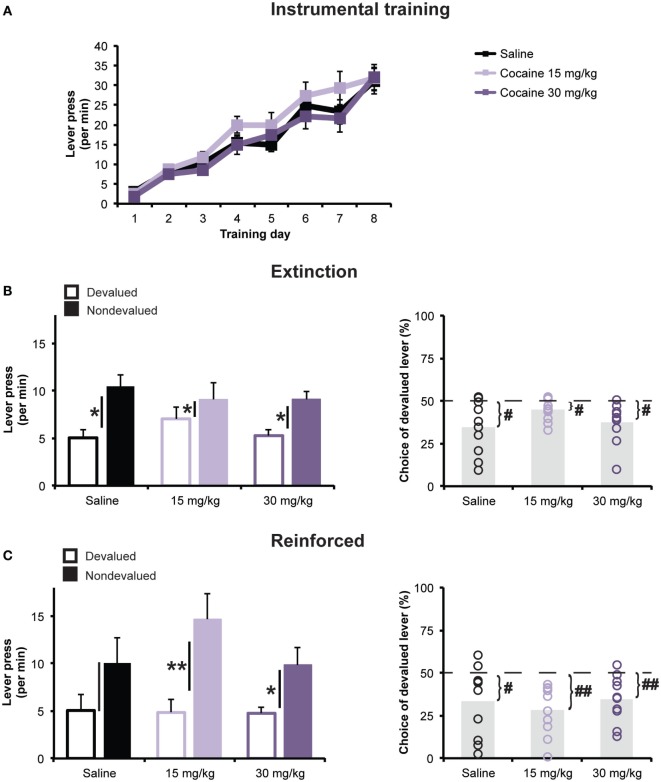
Outcome devaluation. (A) Daily mean (±SEM) rates of lever pressing (presses per minute) during the 8-day of instrumental training following repeated cocaine or saline exposure. (B) Responses during the 5-min extinction phase of the outcome devaluation test. Left panel: mean lever press rate (±SEM) on Devalued and Non-devalued levers. Black bars represent ±SEM of within-subject difference score (Non-devalued–Devalued). *p < 0.05 Devalued vs. Non-devalued. Right panel: mean (±SEM) percentage of all lever presses performed on the Devalued lever. #p < 0.05 vs. 50%. (C) Responses during the 15-min reinforced phase of the outcome devaluation test on Devalued and Non-devalued levers. Black bars represent ±SEM of within-subject difference score (Non-devalued–Devalued). *p < 0.05 and **p < 0.01 Devalued vs. Non-devalued. Left panel: mean lever press rate (±SEM). Right panel: mean (±SEM) percentage of all lever presses performed on the Devalued lever. #p < 0.05 and ##p < 0.01 vs. 50%.